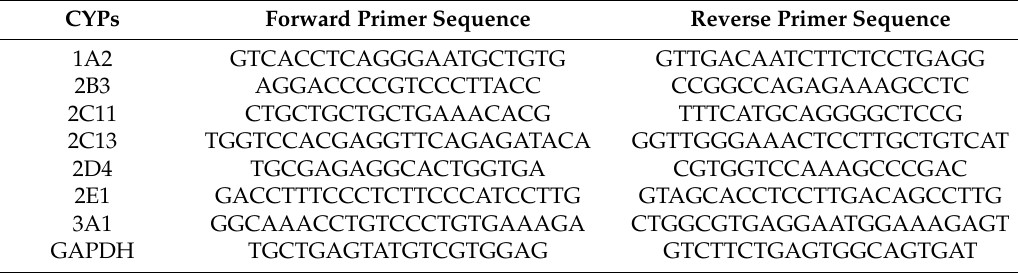
Table 6. Sequences of primers for RT-PCR